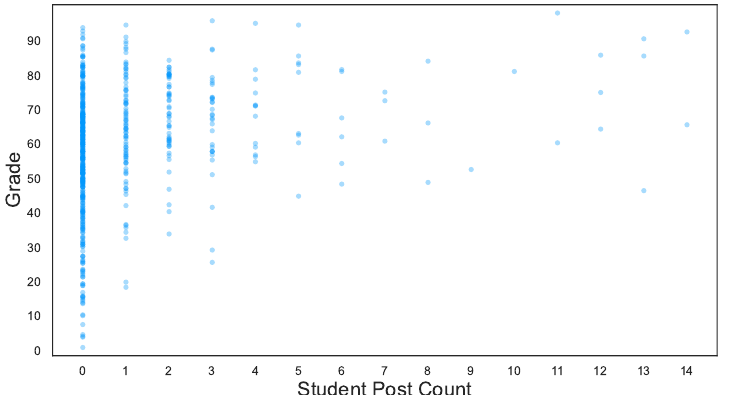
Figure 8. Crude Post Count against Student Grade. There was a positive relationship between Post Count and Grade that was not suitable for a linear OLS